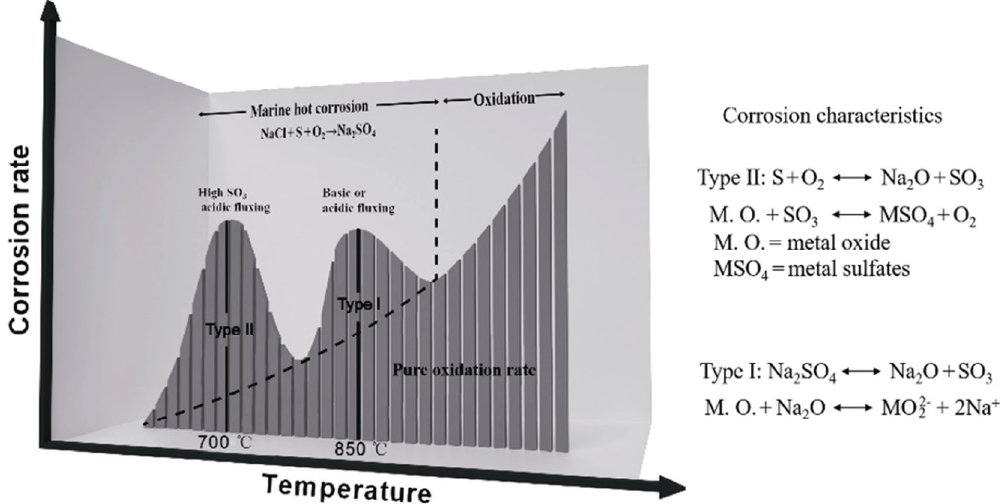
Fig. 53 Profile of shipboard engine corrosion rates of Type I and Type II hot corrosion vs. temperature in a marine environment compared to the Arrhenius oxidation rate vs. temperature. Reproduced with permission from Ref. [281], © Elsevier B.V. 2012; Ref. [282], © China Academic Journal Electronic Publishing House